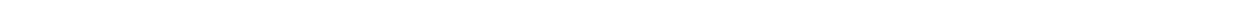
Fig. 2 Frequency distribution of mutant/wild-type ratios for metabolic parameters, separated for males and females. a T0 females, basal blood glucose excursions after glucose injection in a glucose tolerance test, d AUC females, area under the curve of blood glucose excursions after glucose injection in a glucose tolerance test, e TG females, plasma triglyceride concentrations, f TG males, plasma triglyceride concentrations, g body mass females, h body mass males, i MR females, metabolic rate obtained from a 21 h indirect calorimetry trial, j MR females, metabolic rate obtained from a 21 h indirect calorimetry trial, k VO 2 females, oxygen consumption obtained from a 21 h indirect calorimetry trial, l VO 2 males, oxygen consumption obtained from a 21 h indirect calorimetry trial, m RER females, respiratory exchange ratio, n RER females, respiratory exchange ratio. Filled areas of the distributions cover the < 5% and > 95% strong metabolic phenotype genes, n provides number of mutant